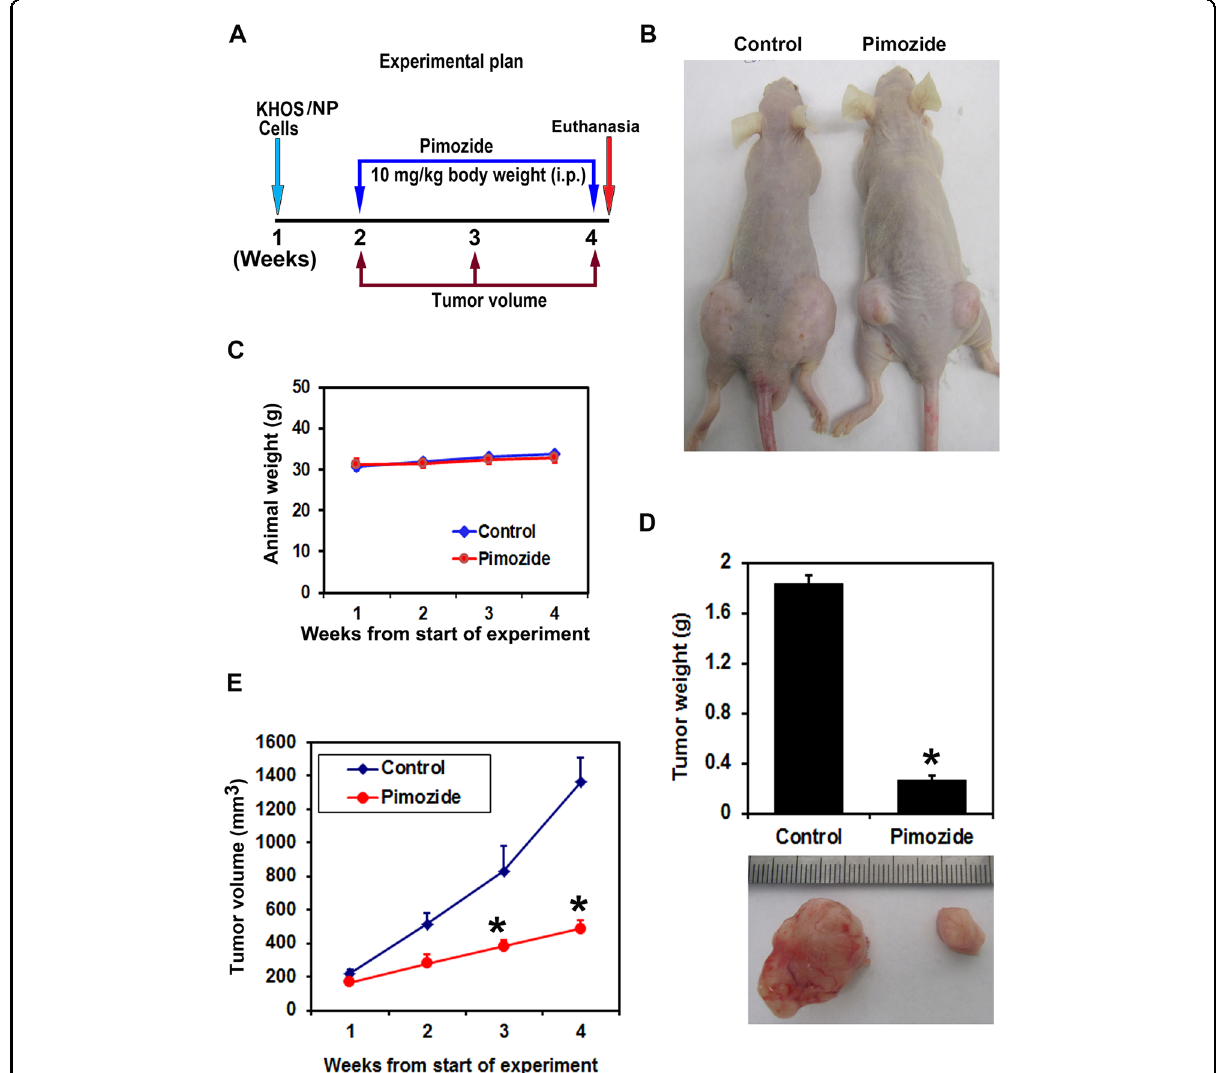
Fig. 6 Pimozide inhibits KHOS/NP induced osteosarcoma tumor xenograft growth. a Experimental plan, b KHOS/NP cells were injected in to the fl anks of nude mice and palpable tumors were allowed to develop for 7 days. Subsequently, pimozide (10 mg/kg bw) was injected daily intraperitoneally every day for 21 days. Tumor size was measured every week. On day 22, tumors were excised and subject to further analyses. c Pimozide treatment did not reduced the animal weight. d Tumor weight in pimozide treated mice were smaller when compared to control (* P < 0.004). e Pimozide treatment signi fi cantly reduced tumor volumes (* P < 0.001). Error bars represent means ± SEM ( N = 5 for each group). * P < 0.05, Student ’ s